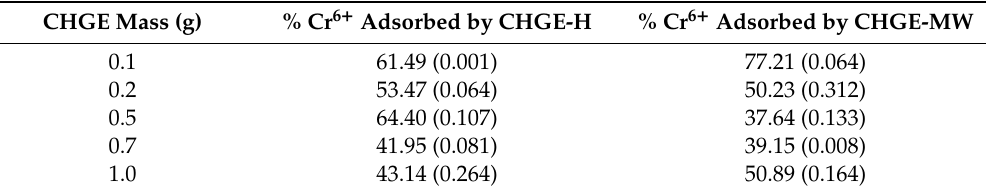
Table 3. The variation of Cr 6 + (%) adsorbed by increasing masses of CHGE in contact with 1 ppm Cr 6 + enriched solution for 24 h.